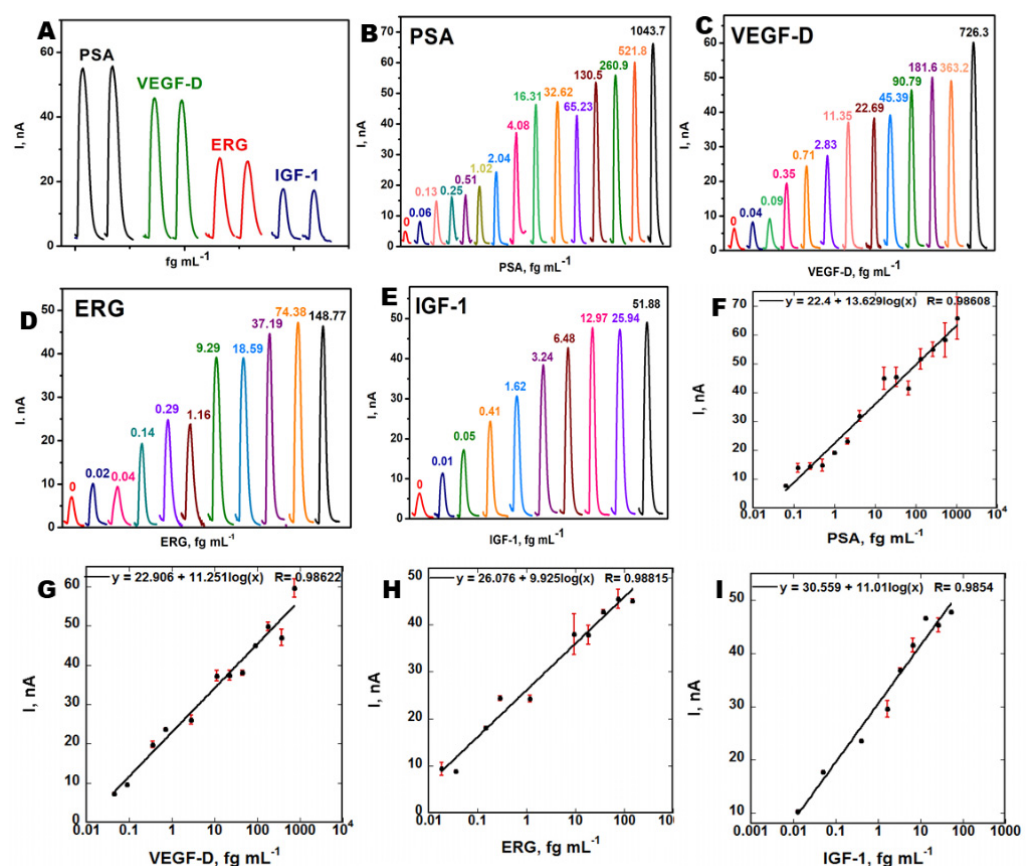
Figure 8. Calibration plots obtained with ( A ) duplicate amperometric peaks of PSA, VEGF-D, ERG, and IGF-1 showing reproducibility; ( B–E ) show amperometric peaks obtained for each biomarker standard; and ( F–I ) show the calibration plots with dynamic ranges from 0.013 to 1000 fg mL − 1 . Reprinted with permission from [17], copyright 2020 American Chemical Society.